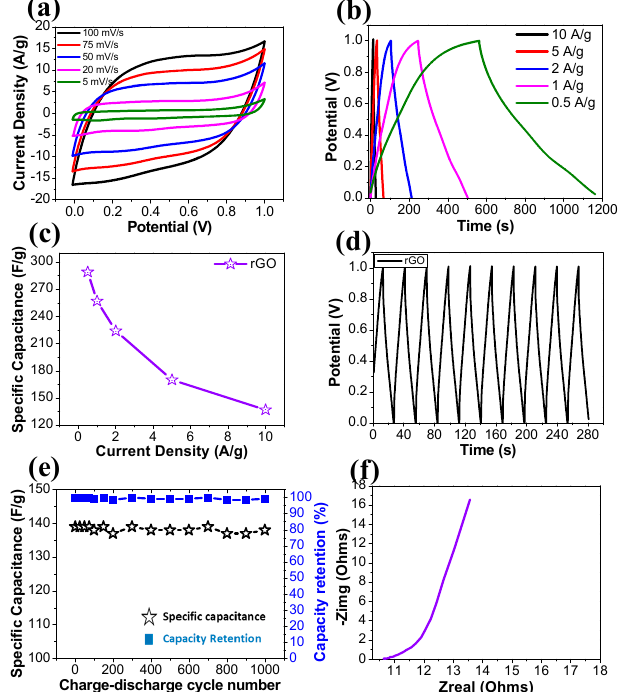
Figure 8. Electrochemical measurements of rGO coated on PLA4Gr6 electrode in 1 M H 2 SO 4 solution: ( a ) Cyclic voltammograms at different scan rates, ( b ) Galvanostatic charge-discharge plots at different current densities, ( c ) Specific capacitance v/s current density plots, ( d ) Starting 10 cycles of charge-discharge, ( e ) Cycle test (till 1000 cycles) and ( f ) Electrochemical impedance spectrum.